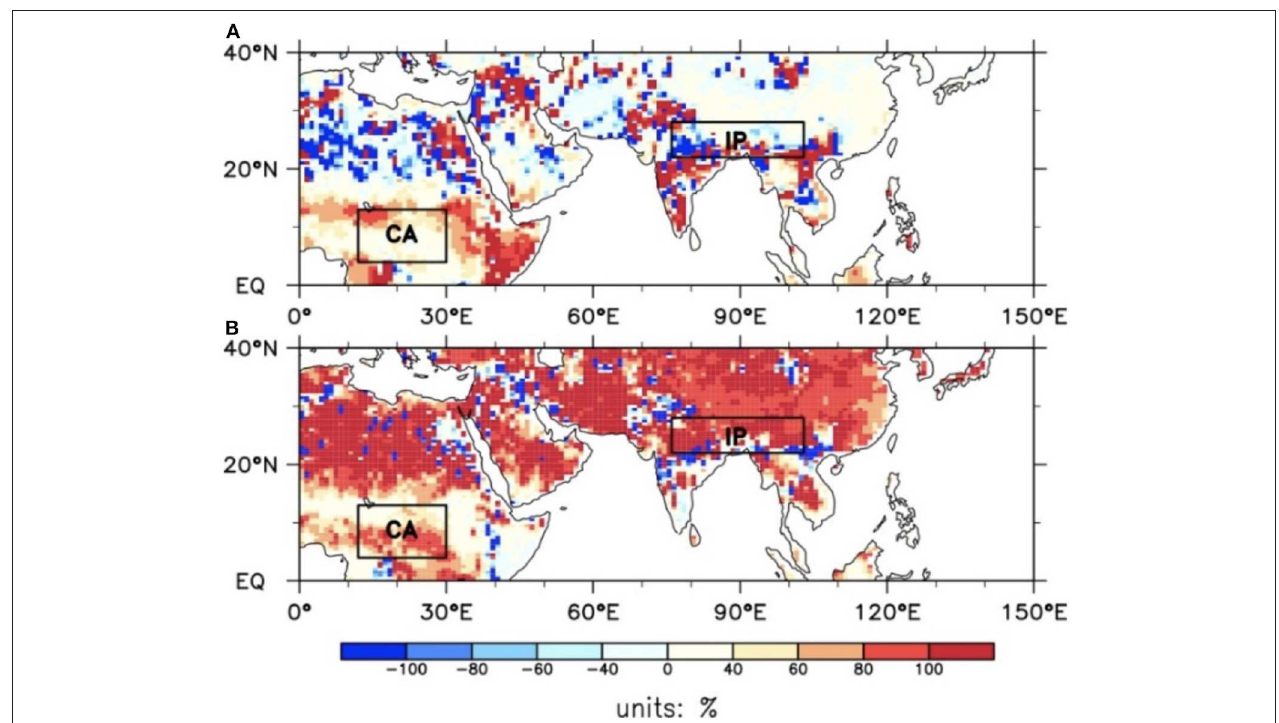
FIGURE 13 | The relative contributions of (A) soil moisture and (B) soil temperature to soil enthalpy trends at mid-low latitudes using GLDAS2.0.